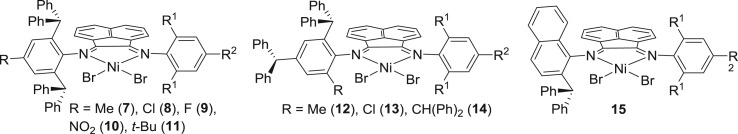
Benzhydryl-containing unsymmetrical α-diiminoacenaphthene-nickel pre-catalysts 7–15.